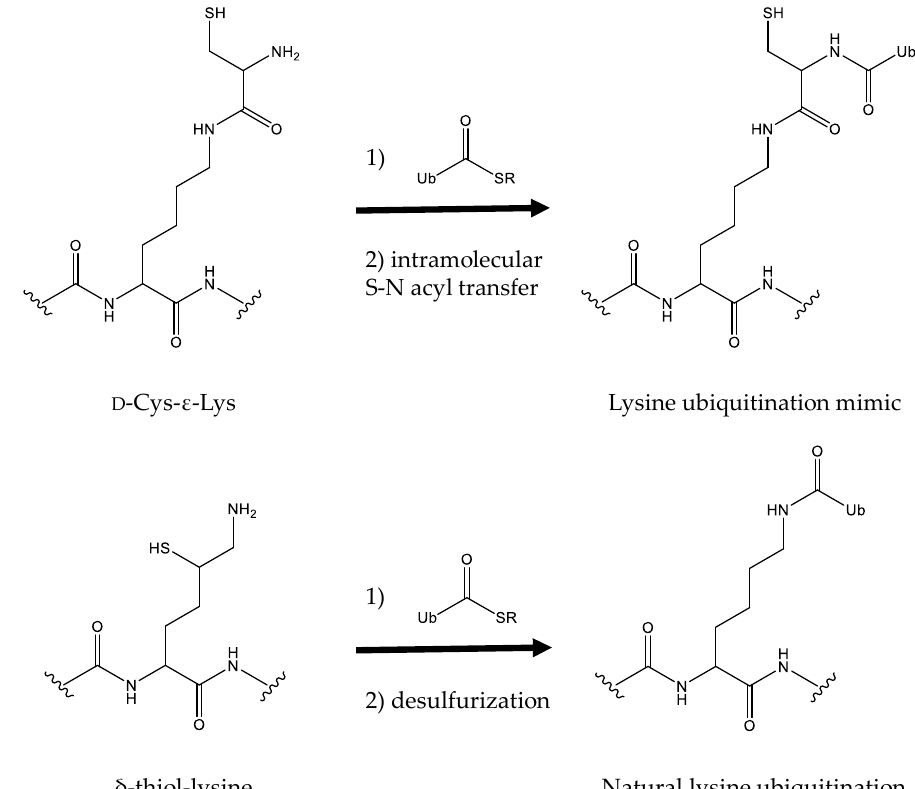
Figure 3. The schemes for producing ubiquitinated proteins. In both approaches, a precursor is genetically incorporated into proteins first, which was linked to a modified ubiquitin harboring a C-terminal thioester by native chemical ligation and then formed ubiquitinated proteins by rearrangement or group removal.